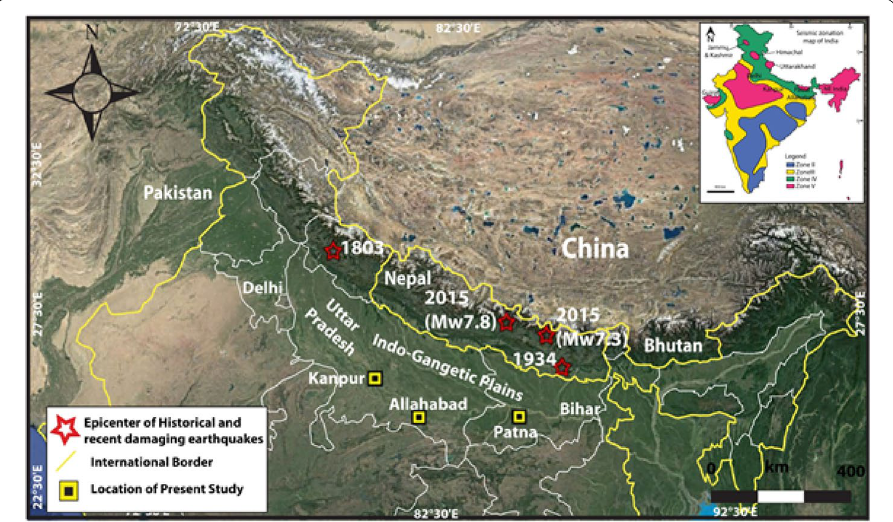
Fig. 1 Map showing the location of historical earthquakes caused shaking around the study area and location of soil samples used in present